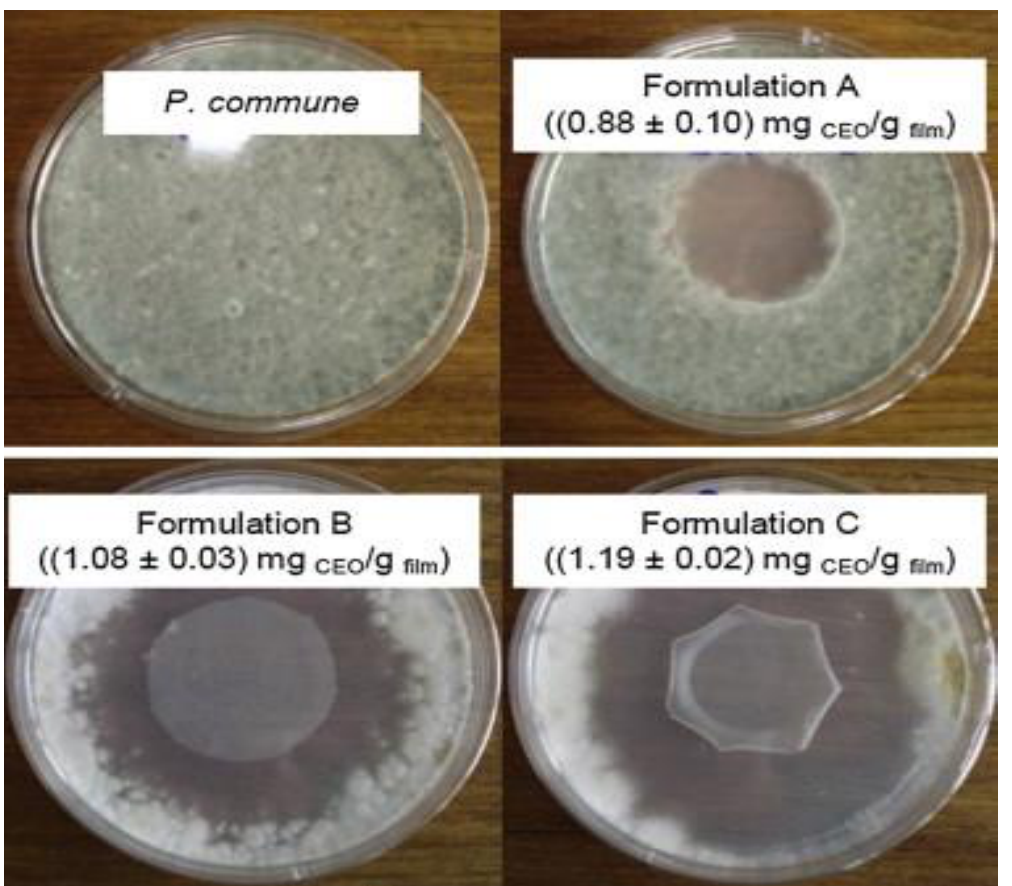
Figure 2. Petri dishes with circular disks of film incorporated with three di ff erent concentrations of cinnamon EOs, showing the inhibitory zone against Penicillium commune in comparison with the Petri dish without the active film. (Reproduced with a copyright permission from Souza et al.